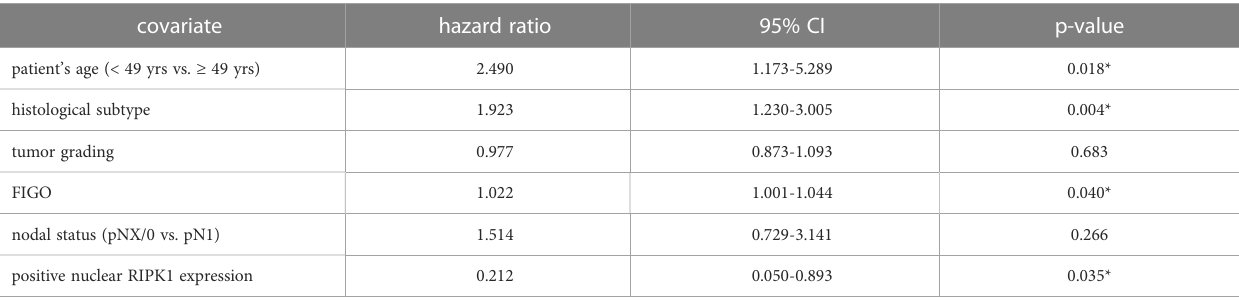
TABLE 2 Multivariate Cox regression analysis of cervical cancer patients ( n = 250) and their clinical and pathological characteristics including nuclear RIPK1 expression regarding OS.